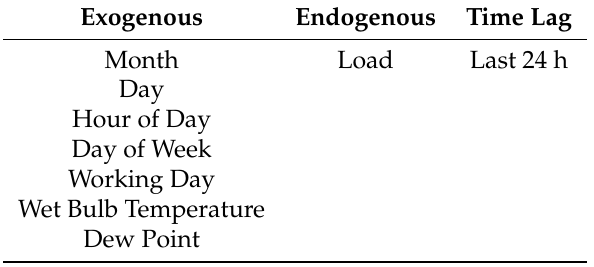
Table 1. ANN model